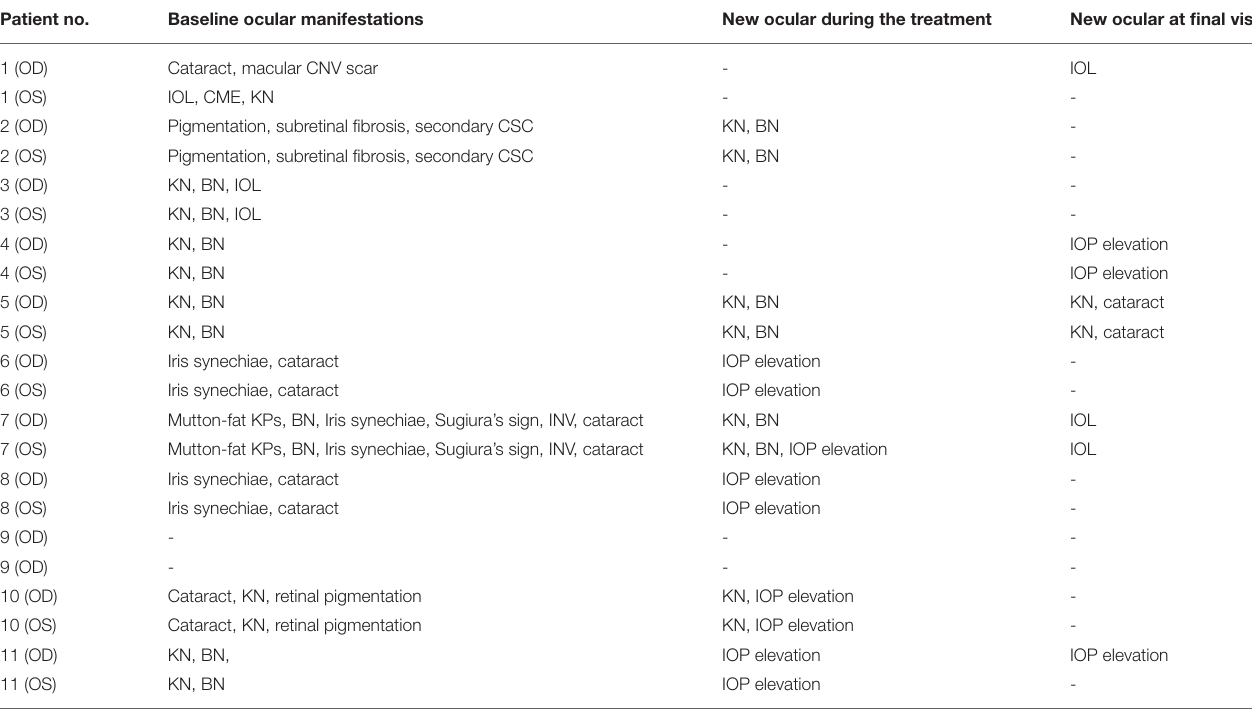
TABLE 3 | Ocular manifestations during the treatment period. Patient